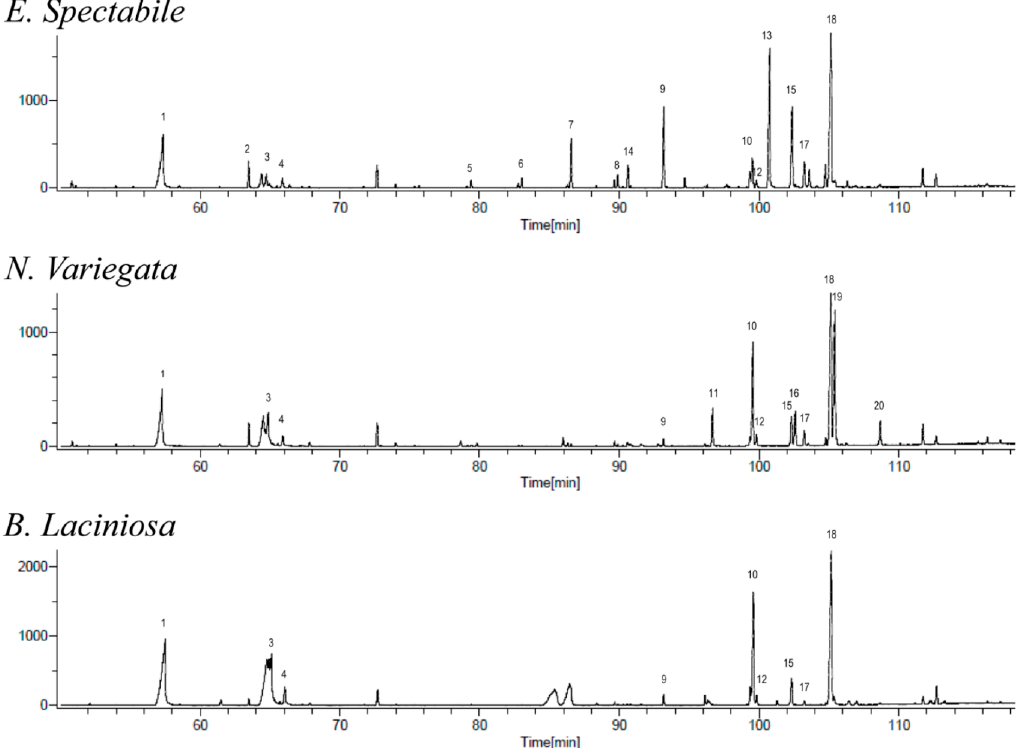
Figure 4. Comparison of TIC for B. laciniosa , N. variegata and E. spectabile .